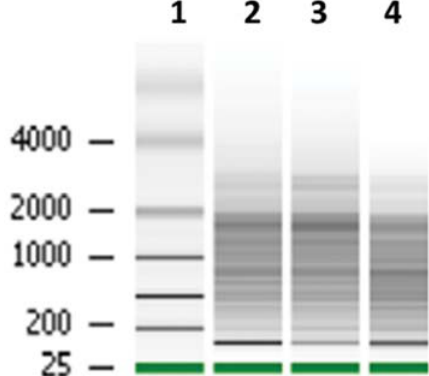
Figure 4. A , Hemolytic pattern of the methicillin-resistant S. aureus (MRSA) isolates BMB9393 and GV69. The arrow indicates the arrow-tip-like zone of d -hemolysin activity on sheep blood agar. B , C , and D , Transcriptional levels of virulence- associated genes determined by real-time RT-qPCR, using the DD CT comparative method. B , agr - rna III, C , psm a 3 , and D , spa . Total RNA was prepared from stationary-phase cells. The USA300 isolate was used as a calibrator. RQ: relative quantity.